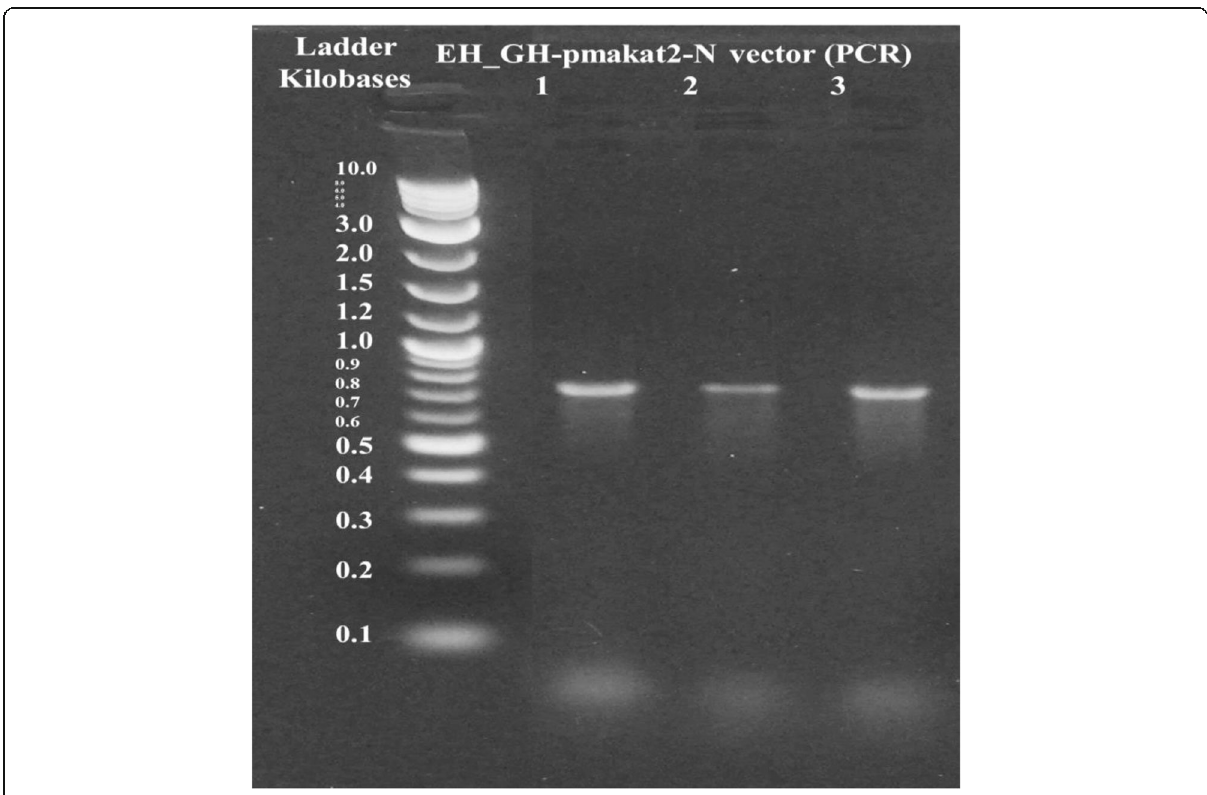
Fig. 4 Electrophoretic pattern of the EH_GH – pmKate2 – N vector band (PCR, 740 bp). Ladder, DNA marker (100 to 10,000 bp); 1, 2, and 3 are the samples of the EH_GH – pmKate2 – N vector